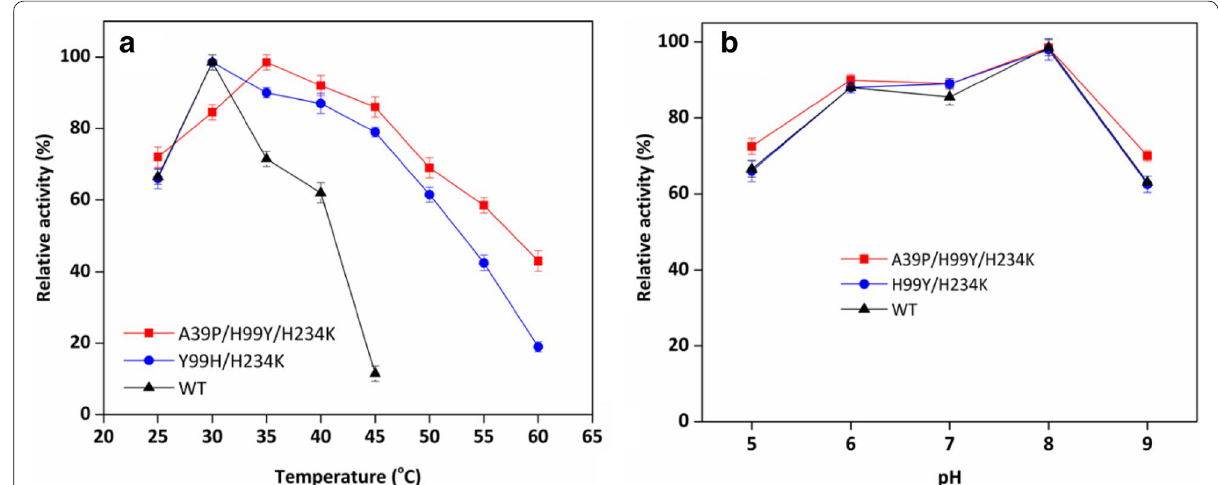
Fig. 4 Optimal temperature and pH values of UDH mutants. ( a ) Optimal temperature was determined in pH 8.0 buffer. ( b ) Optimal pH was determined at 37 °C except for H99Y/H234K and wild‑type UDH (30